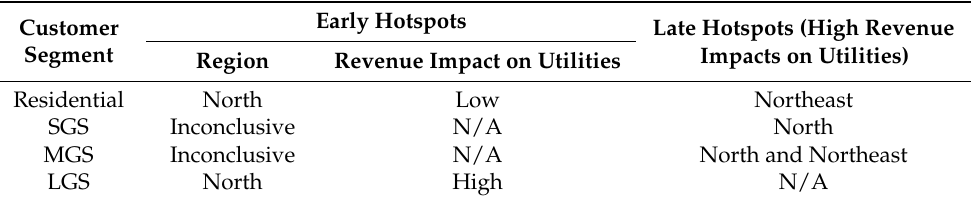
Table 6. Summary of potential hotspots.